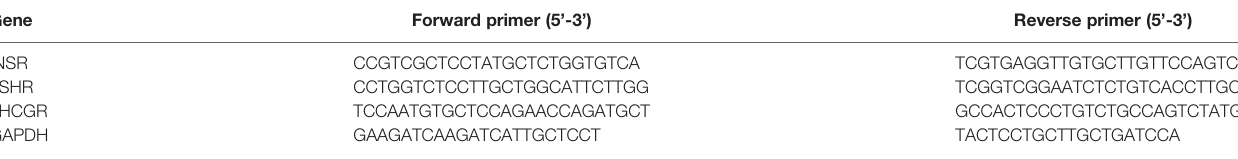
TABLE 1 | Primer sequences of the qRT-PCR